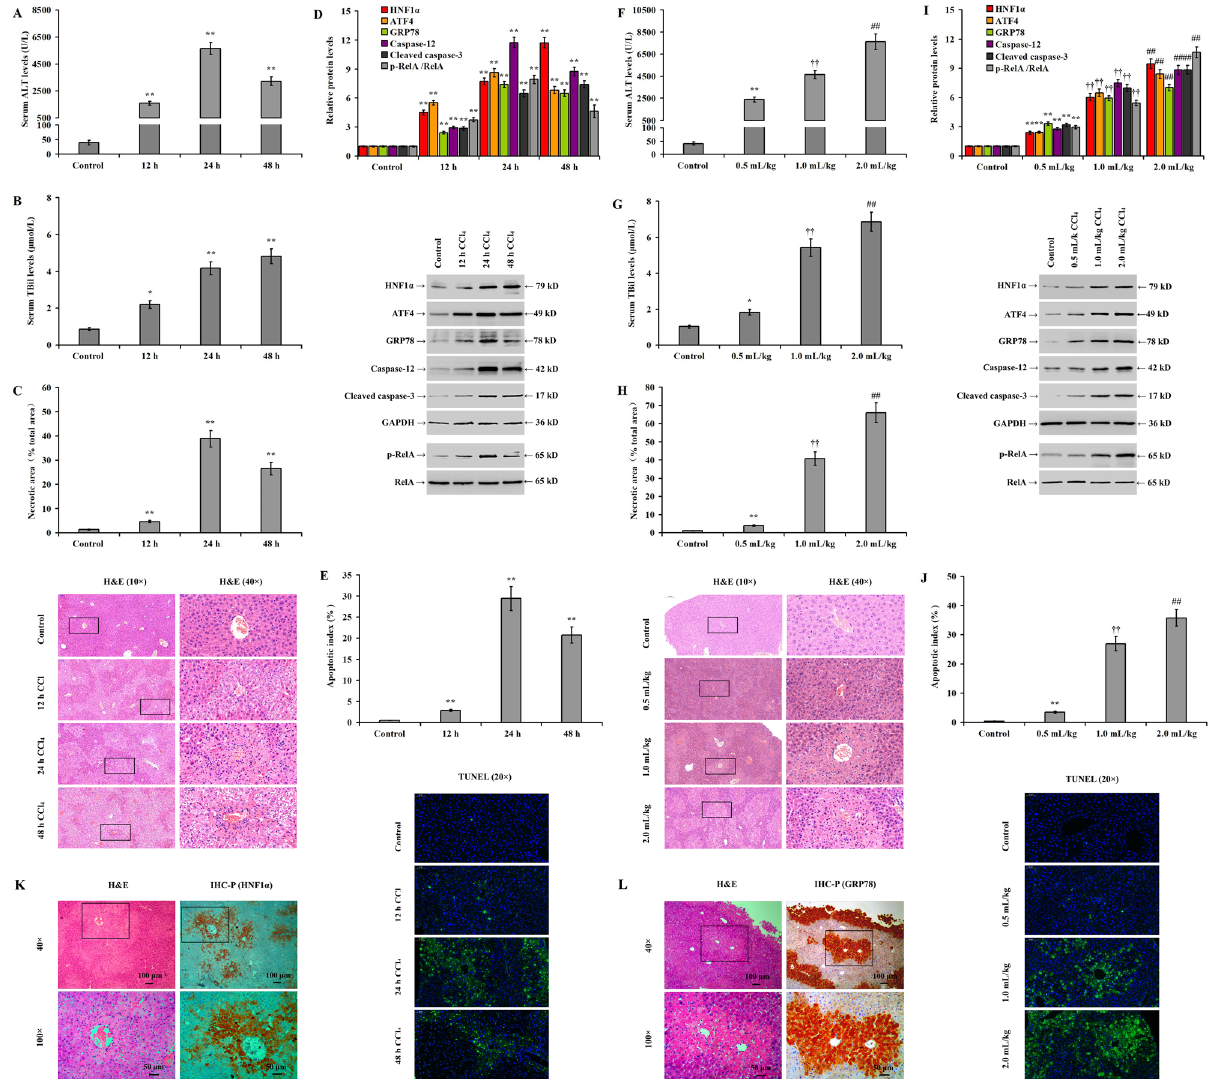
Figure 5. Expression of HNF1α, ER stress, and apoptosis signaling in CCl 4 -induced mice: ( A ) enzymatic rate method was used to detect the time-dependent changes in serum ALT levels in a CCl 4 -induced liver injury mouse model: ( B ) diazonium method to detect the time-dependent changes in serum TBil levels in mice; ( C ) bar charts representing the proportion of necrotic liver tissue area and H&E staining representing the pathological changes in the liver; ( D ) Western blotting reflecting the time-dependent changes in protein expression in CCl 4 -induced liver injury mouse model; ( E ) hepatocyte apoptotic index as measured by TUNEL staining; ( F ) dose-dependent changes in serum ALT levels detected by the enzymatic rate method; ( G ) dose- dependent changes in serum TBil levels detected by the diazonium method; ( H ) bar charts representing the proportion of necrotic liver tissue area and H&E staining representing pathological changes in the liver; ( I ) bar chart representing the relative protein expression levels of each protein; ( J ) bar charts representing the proportion of hepatocyte apoptotic index and TUNEL staining representing apoptotic changes in liver tissue; ( K ) immunohistochemical staining representing HNF1 α expression; and ( L ) GEP78 expression. * p < 0.05, ** p < 0.01 versus the control group. †† p < 0.01 versus the 0.5 mL/kg CCl 4 group. ## p < 0.01 versus the 1.0 mL/kg CCl 4 group. IHC-P: